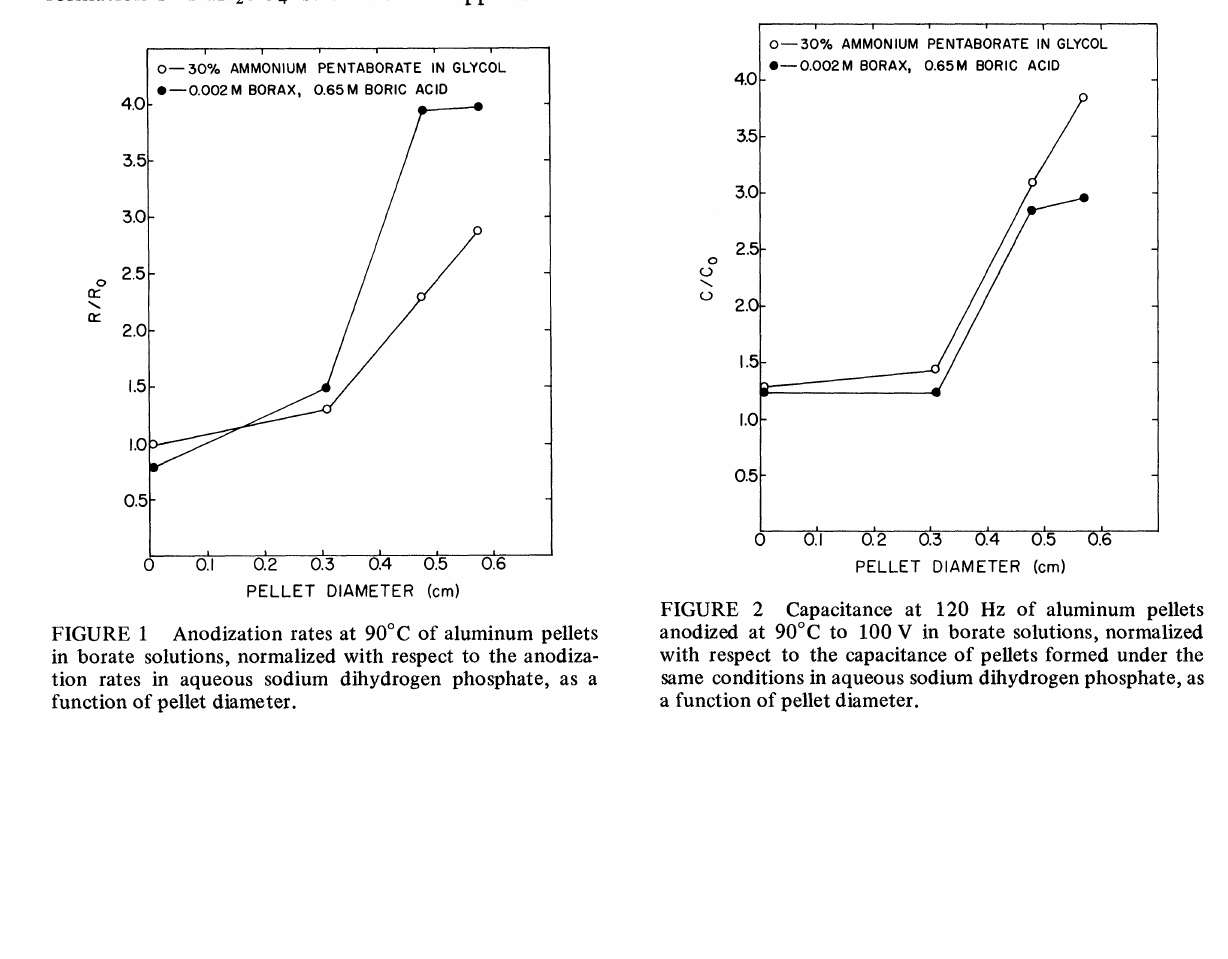
FIGURE 2 Capacitance at 120 Hz of aluminum pellets anodized at 90C to 100 V in borate solutions, normalized with respect to the capacitance of pellets formed under the same conditions in aqueous sodium dihydrogen phosphate, as a function of pellet